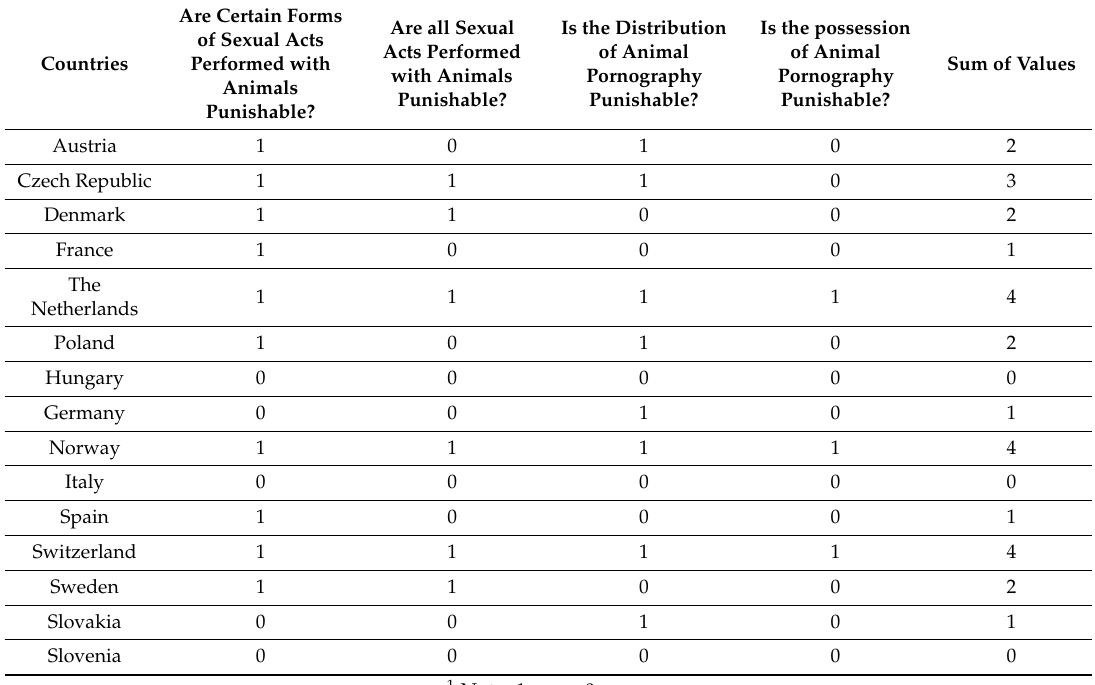
Table 1. Evaluation of 15 European countries according to the criminal regulation of zoophilia. 1.